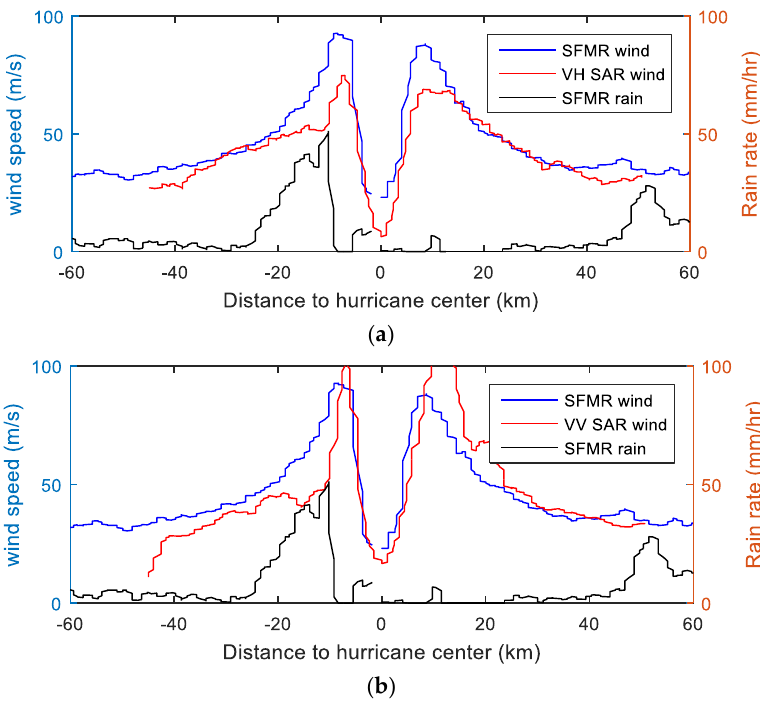
Figure 4. SAR wind speed retrieved from ( a ) cross-polarization (cross-pol), and ( b ) co-polarization (co-pol) profiles, overlaid with the rain rate along the airborne track of the NOAA43 stepped frequency microwave radiometer (SFMR) measurements.